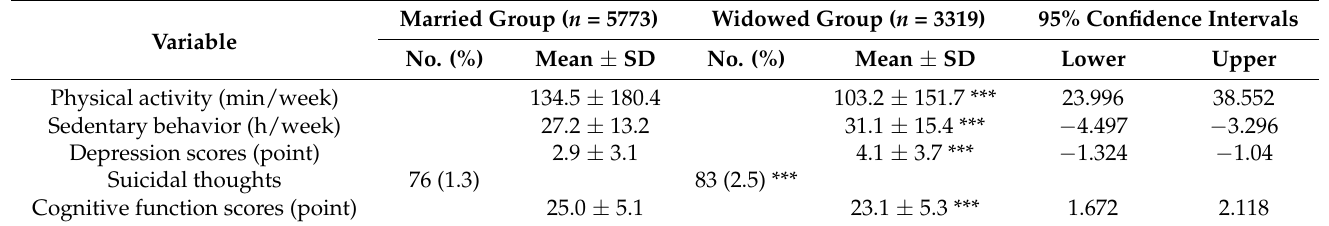
Table 2. Comparison of physical activity, sedentary behavior, and mental health between the married and widowed